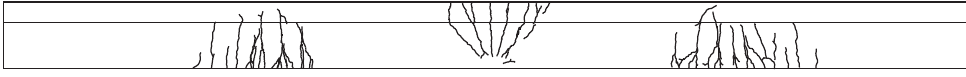
Figure 22: Cracks in test beam CCB-2.